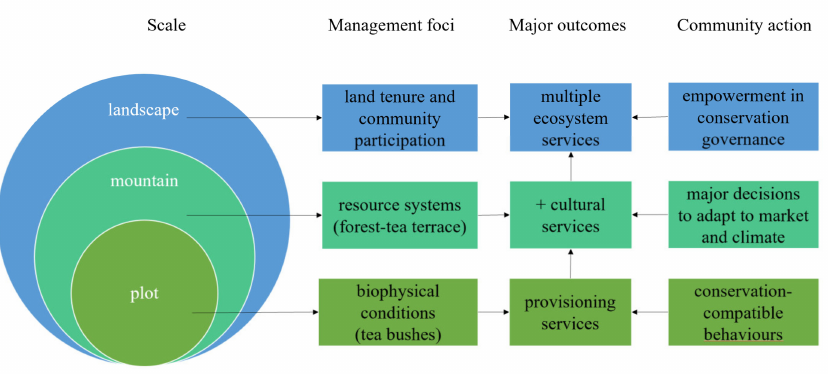
Figure 7. A scaling management strategy for adapting agroforestry systems to conservation in mountainous